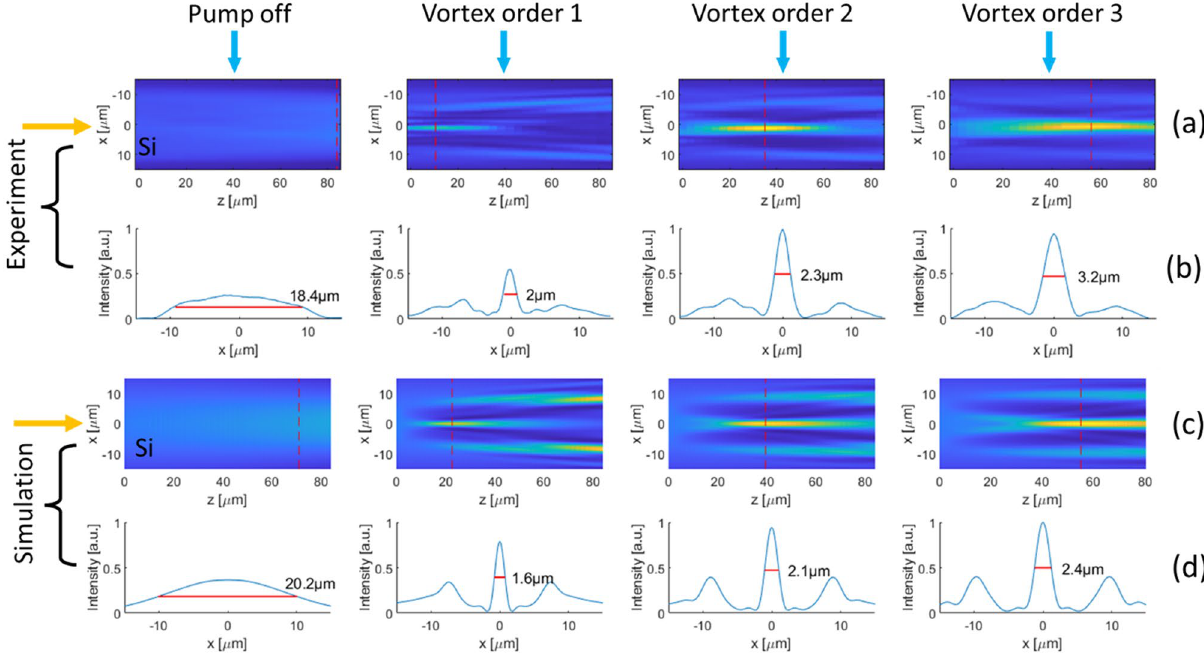
Figure 9. Experimental and simulation results for probe’s focusing inside the silicon. The experimental results are compared to the simulation results and are shown for the shaped probe beam. The lasers illuminate the silicon sample from left to right as indicated by the yellow arrows. In rows ( a ) and ( c ) we show Images of the trajectories of the probe beam inside the silicon in 4 cases. In the first case without the pump beam (the left column) and in the other three cases the pump beam applied in three different vortex’s topological orders 1, 2 and 3. In rows ( b ) and ( d ) we show the profile of the probe beam at the focal point (indicated on each image by a dashed vertical red line) in the four cases. The simulation results are in good correlation with the experimental